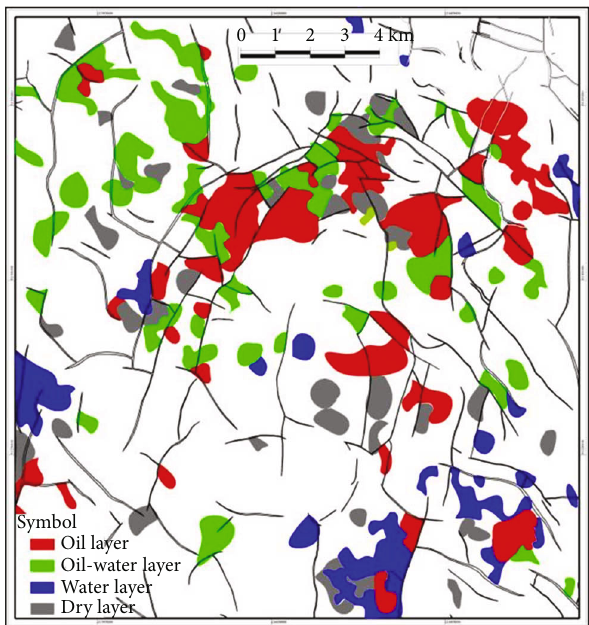
Figure 3: Medium of oil and water distribution in Portugal I.